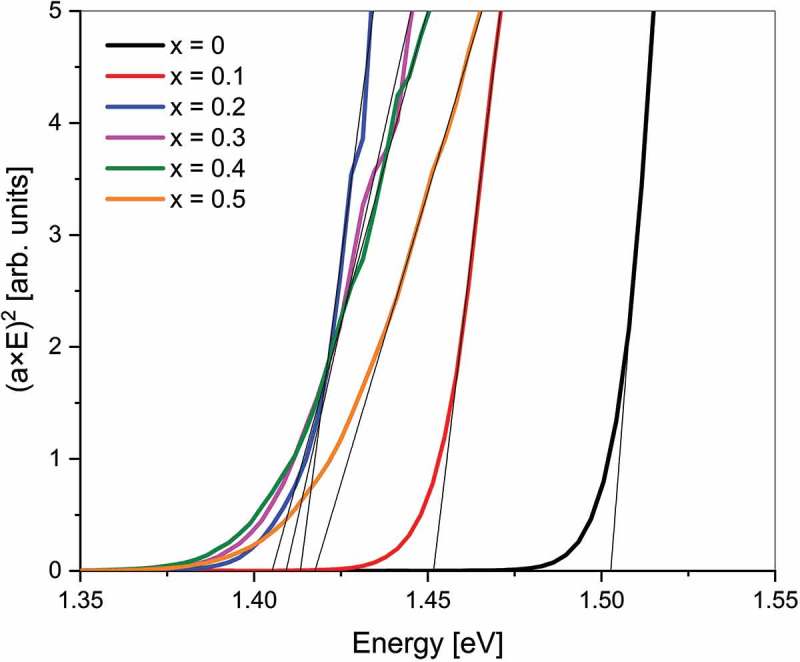
Tauc plots of CdTe1-xSex thin films on glass substrate with linear fitting to extract the band gap.